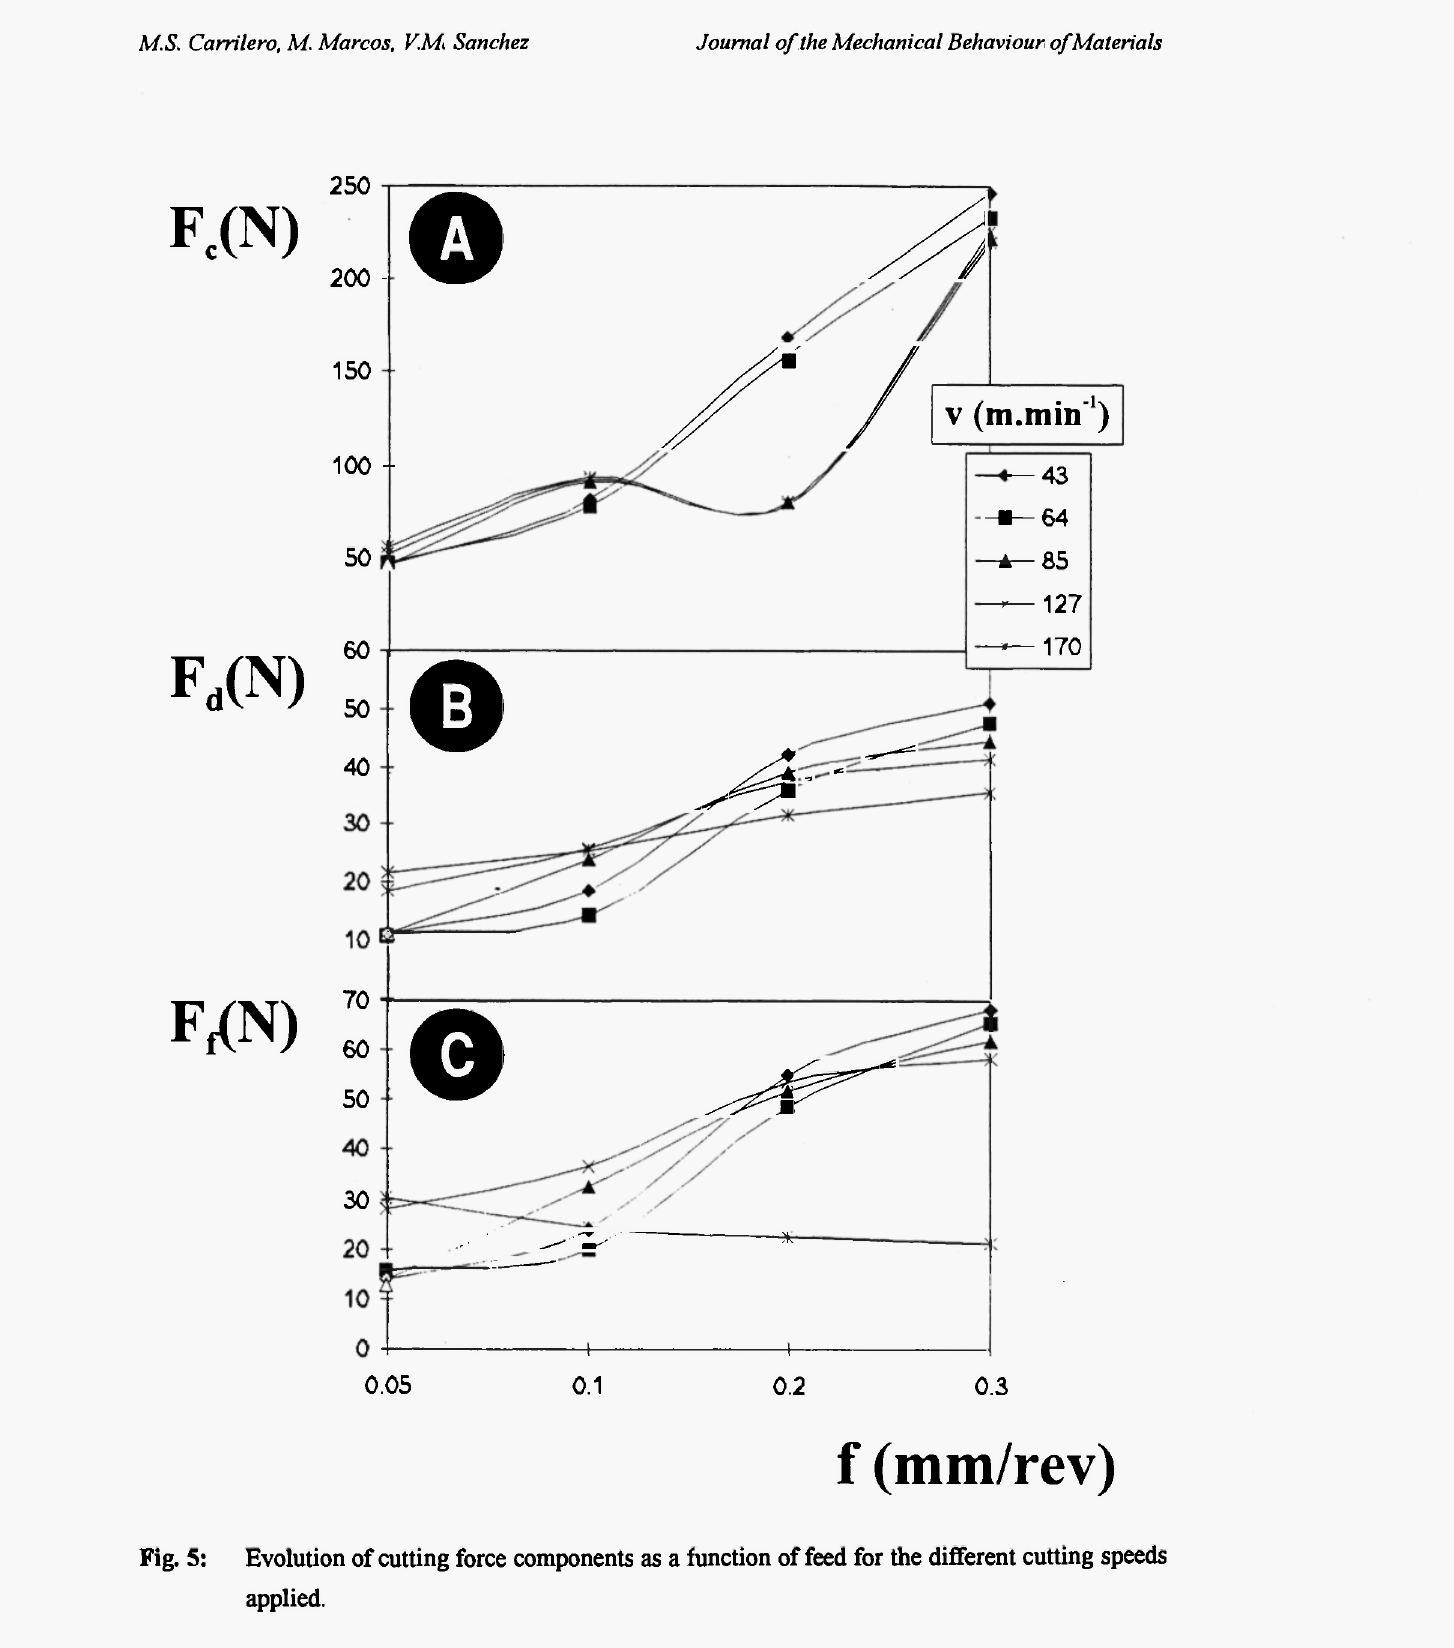
Fig. 5: Evolution of cutting force components as a function of feed for the different cutting speeds